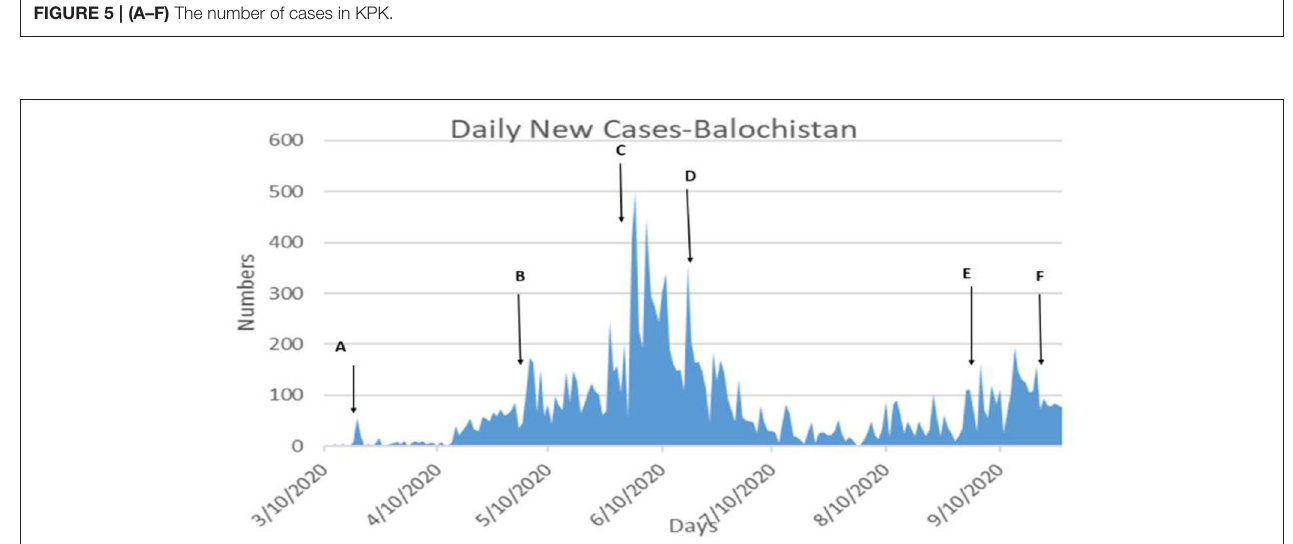
FIGURE 5 | (A–F) The number of cases in KPK.